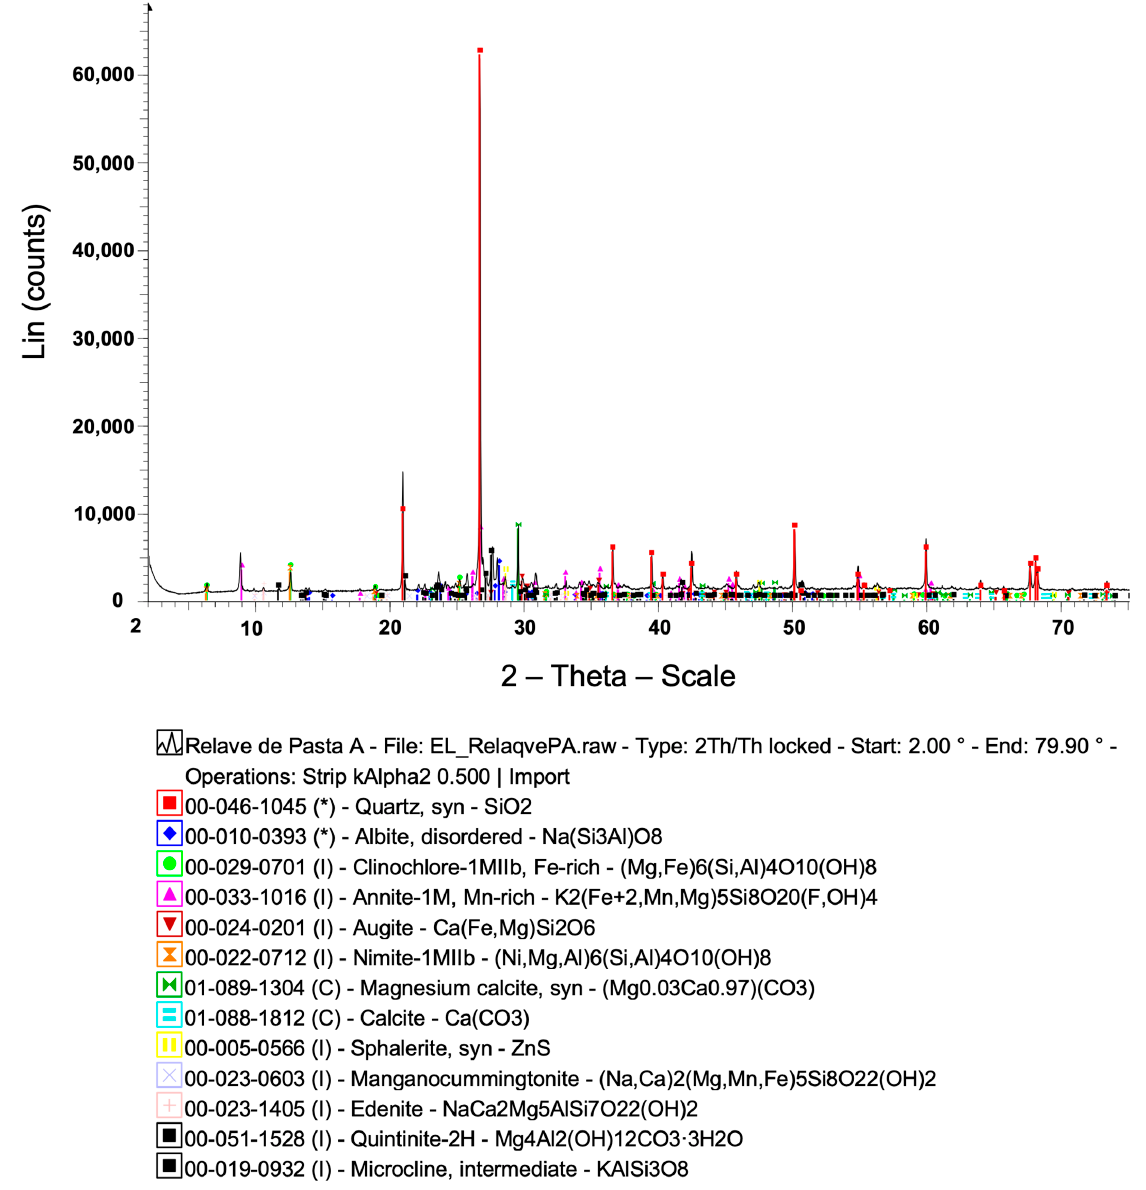
Figure A1. Representative X-ray diffraction (XRD) pattern of paste tailing samples (T4). The presence of crystalline phases is observed, although dominance of amorphous minerals is also evidenced.